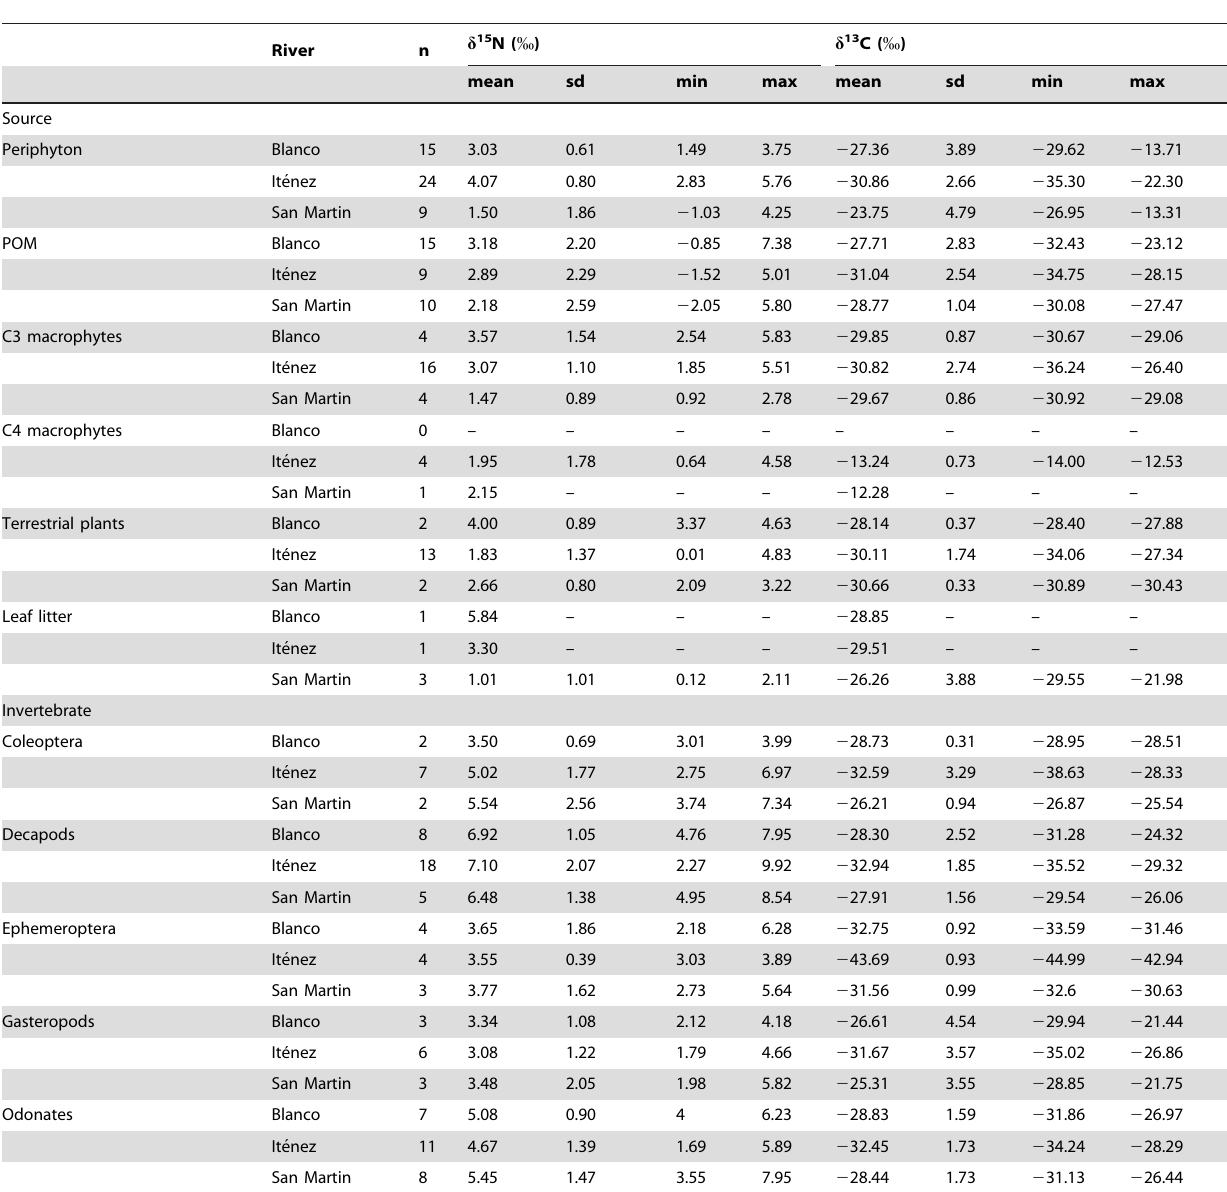
Table 1. Isotopic composition ( d 15N, d 13C) of food sources and invertebrates in three rivers of the Ite´nez basin.